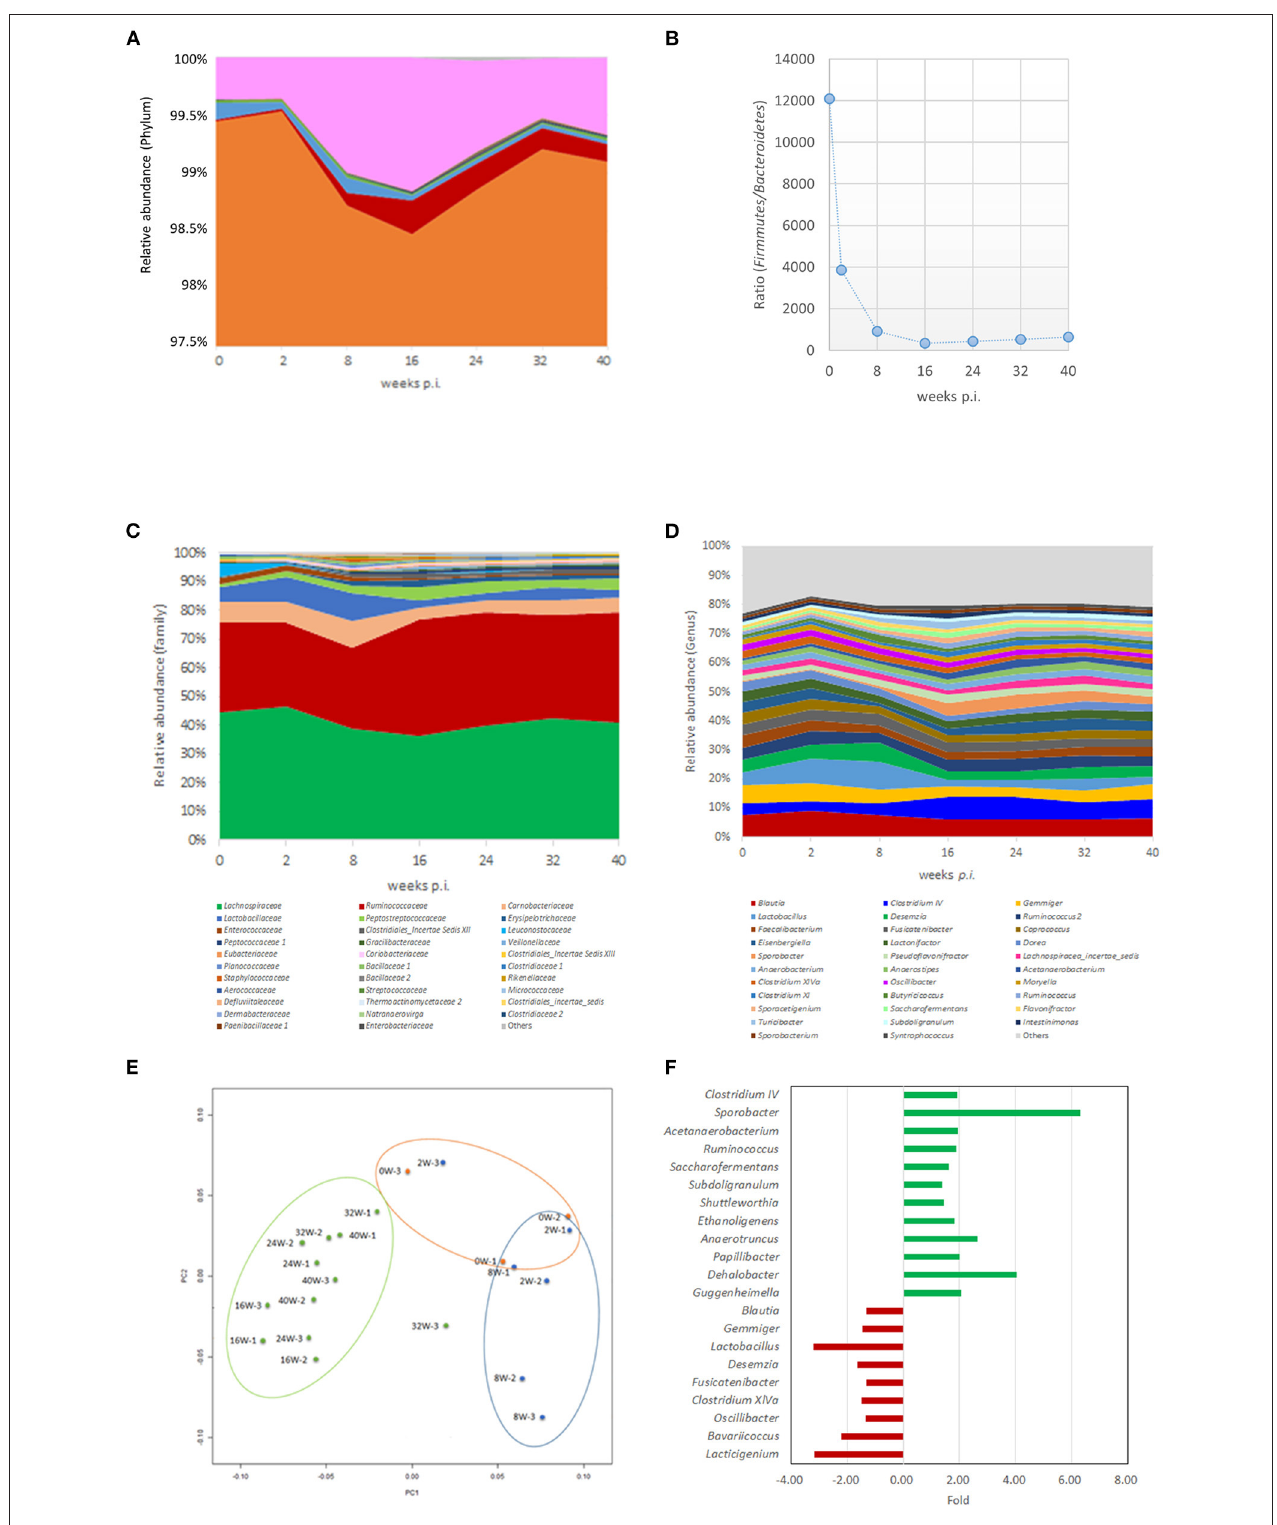
FIGURE 2 | Altered microbiome in the caecum of laying hens during infection experiments. (A) Time-dependent dynamics of representative bacterial phylum as detected in caecal samples of laying hens. (B) Time-dependent dynamics of the Firmicutes / Bacteroidetes (F/B) ratio of the caecal microbiomes. (C)